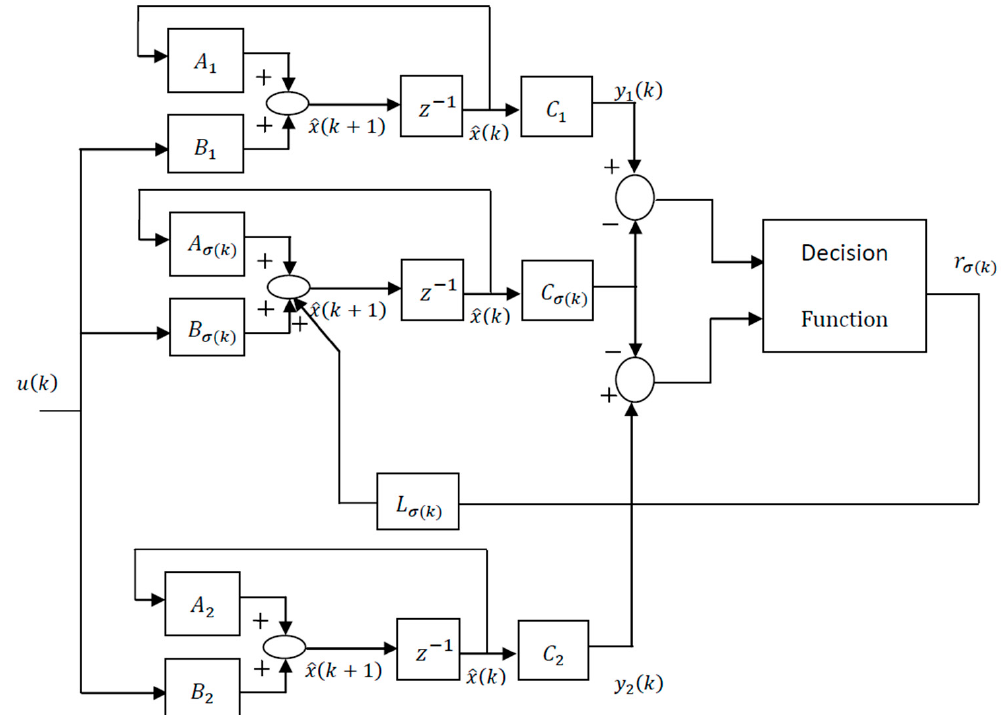
Figure 1. Scheme of the multi-measurement mode estimation-based switching observer.